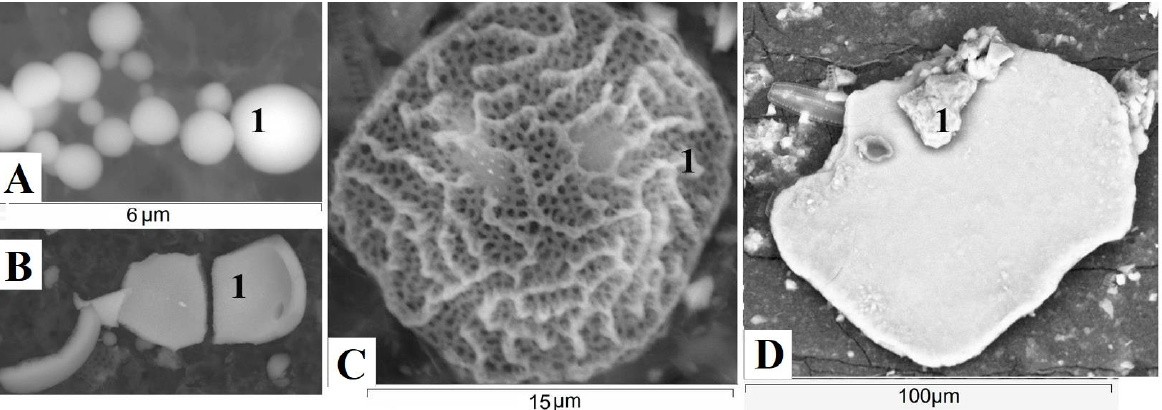
Figure 10. Micrographs made using SEM of aggregates of iron minerals of various morphologies in river suspensions on filters taken in the rivers Vodla ( A ), Andoma ( B ), Shuya ( C ) and Sheltozerka ( D ): ( A ) 1 — spherical aggregates of goethite; ( B ) 1 — spherical fragments of goethite aggregate; ( C ) 1 — goethite cellular aggregate; ( D ) 1 — large particle of organic matter covered with a film of native iron.